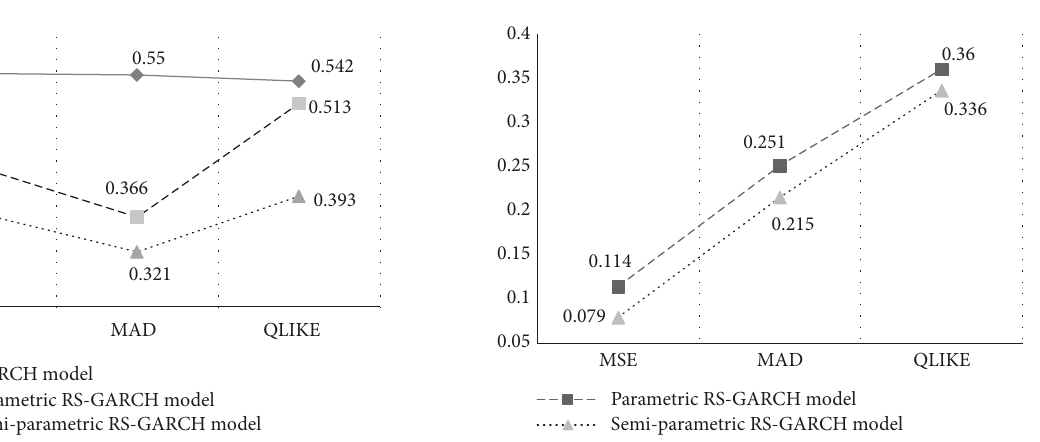
Figure 5: The model fitting error results in sample period (SSE 50).